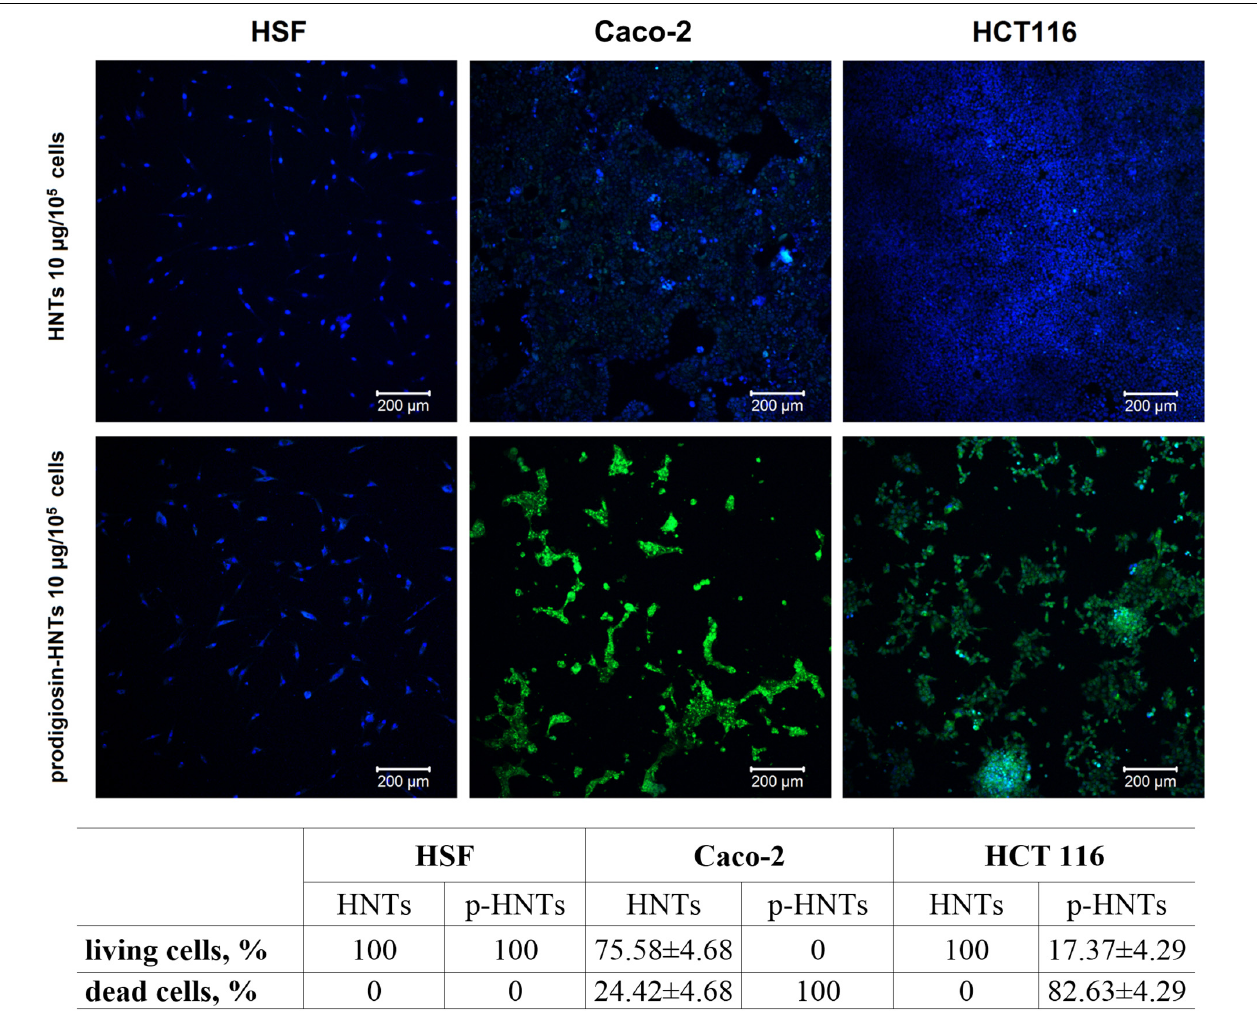
FIGURE 5 | Live/Dead staining (green – dead cells, blue – living cells, Live/Dead kit (Life Technologies) of cells treated with HNTs and prodigiosin-HNTs (p-HNTs). Living cells appear blue and dead cells appearing green on the color-coded confocal